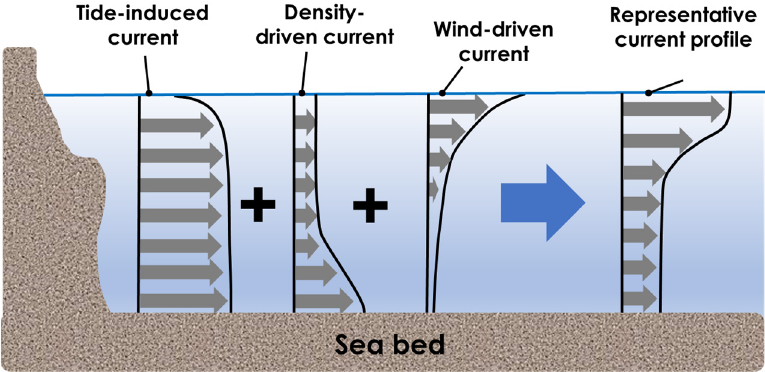
Figure 1. The schematic of the representative current